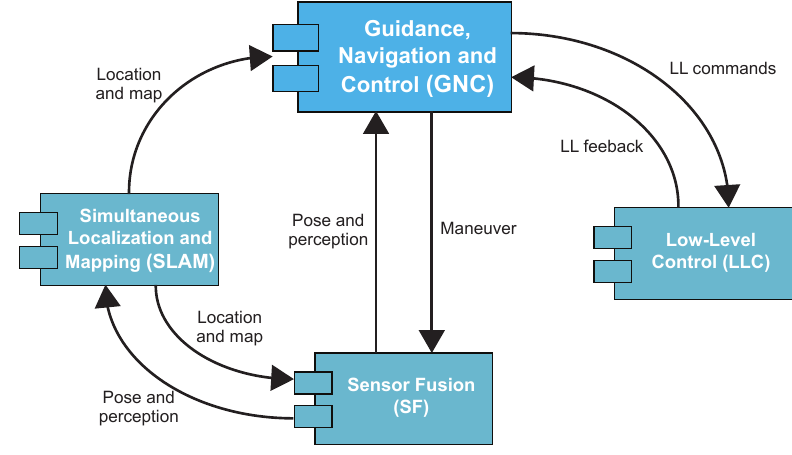
Figure 4. The UX-1 software